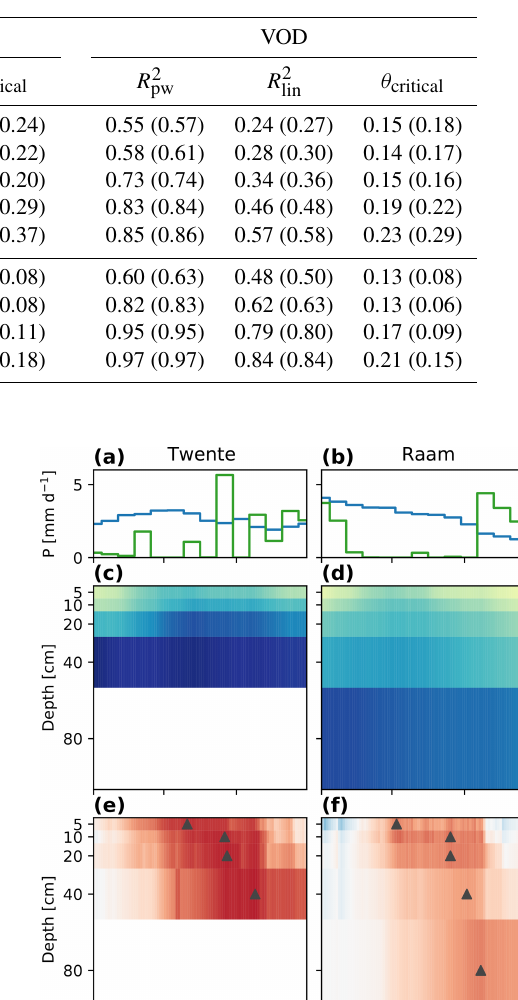
Table 1. Fit statistics and resulting critical soil moisture content based on both NIRv and VOD data. R 2 piecewise (pw) and linear (lin) fits, adjusted for the number of parameters used in the fit; the value in brackets shows the standard R 2 value. The critical soil moisture content in brackets is the value normalized between minimum and maximum moisture content values at each integration depth.